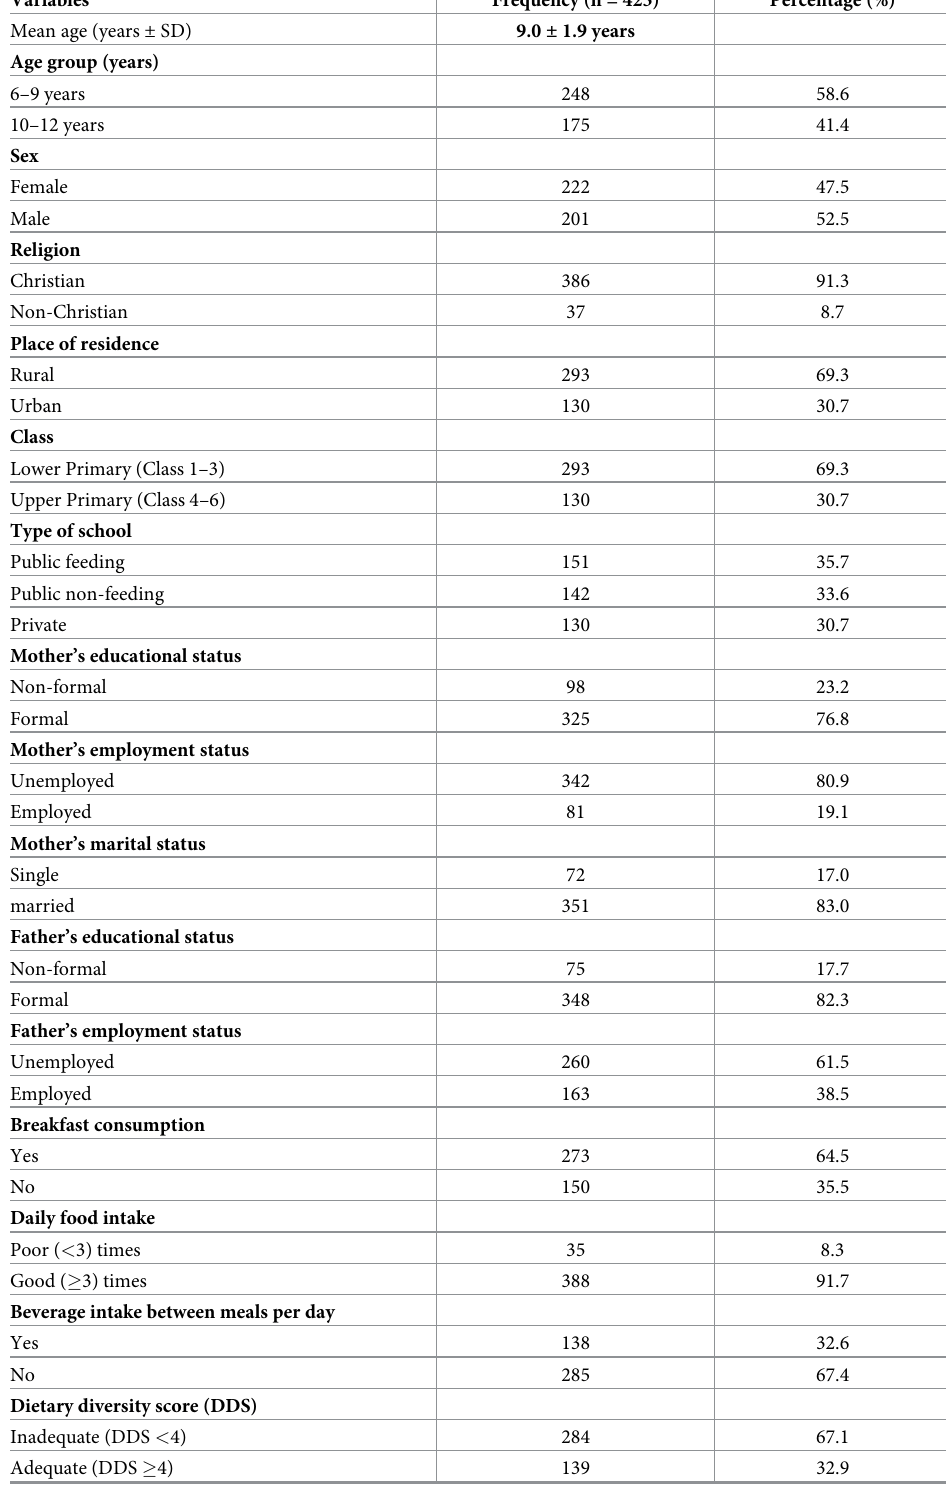
Table 1. Sociodemographic and background characteristics of the respondents (n =